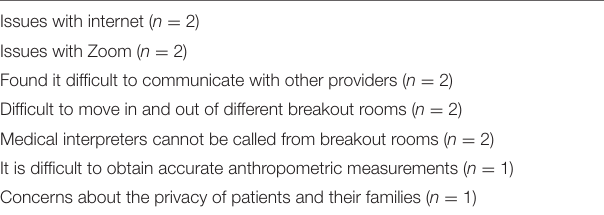
TABLE 2 | Provider-identified difficulties with telemedicine. Issues with internet ( n =